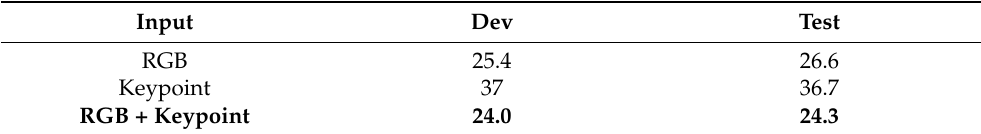
Table 1. WER Performance comparison using single stream and multi-stream